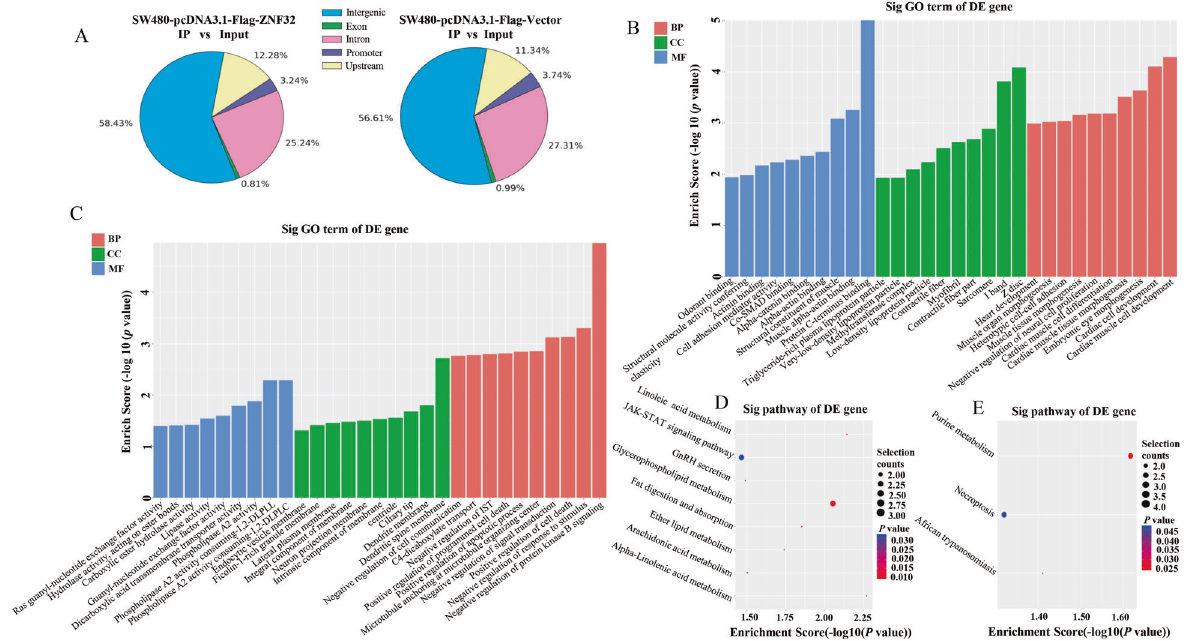
Fig. 4 ChIP-sequence analysis of CRC cells. ( A ) ChIP-sequence analysis identi fi ed 1,235 peak genes in the SW480-pcDNA3.1-Flag-ZNF32 group and 1639 peak genes in the SW480-pcDNA3.1-Flag-Vector group. The data presented here are from one representative experiment of three independent experiments. ( B ) GO analysis of upregulated genes between SW480-pcDNA3.1-Flag-ZNF32 and SW480-pcDNA3.1-Flag- Vector cells. The data presented here are from one representative experiment of three independent experiments. ( C ) GO analysis of downregulated genes. The data presented here are from one representative experiment of three independent experiments. ( D ) KEGG pathway analysis of upregulated genes between SW480-pcDNA3.1-Flag-ZNF32 and SW480-pcDNA3.1-Flag-Vector cells. The data presented here are from one representative experiment of three independent experiments. ( E ) KEGG pathway analysis of downregulated genes between SW480-pcDNA3.1-Flag-ZNF32 and SW480-pcDNA3.1-Flag-Vector cells. The data presented here are from one representative experiment of three independent